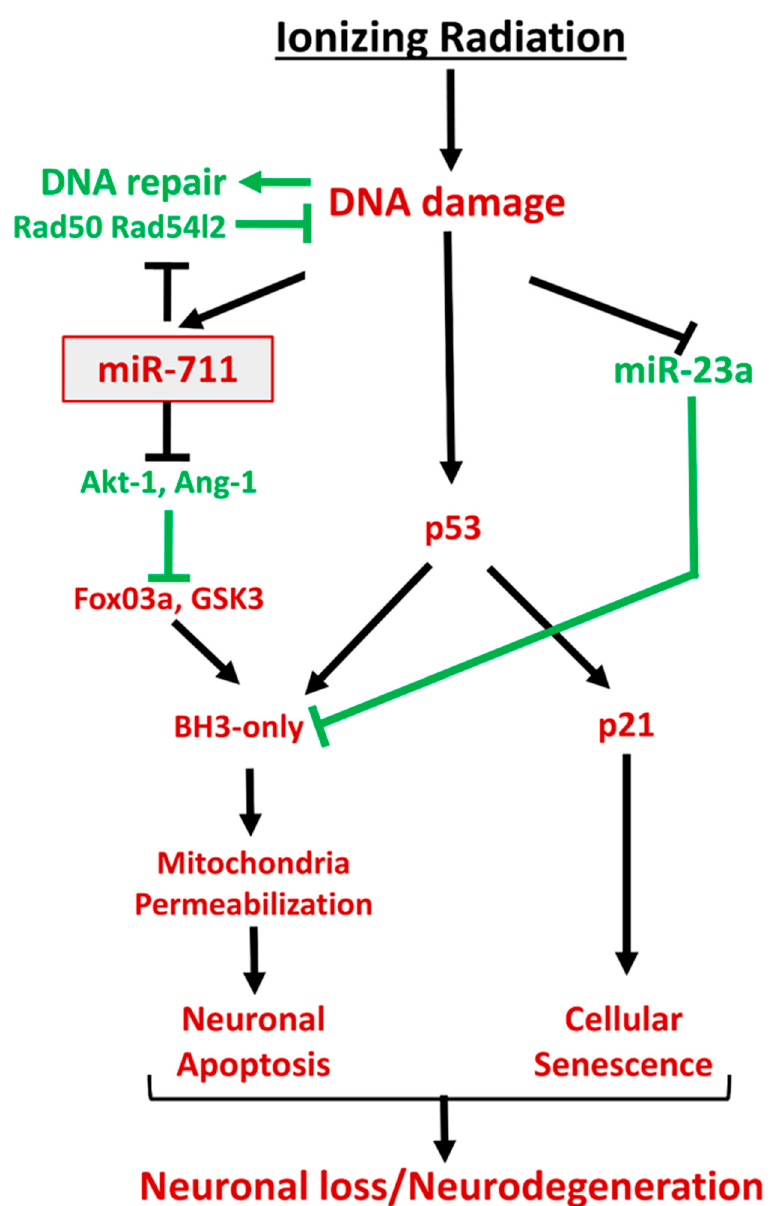
Figure 10. The schematic illustration of the role of miR-711 and miR-23a-3p on the IR-induced neuronal outcome. Pro-apoptotic events are shown in red, anti-apoptotic events are shown in green.